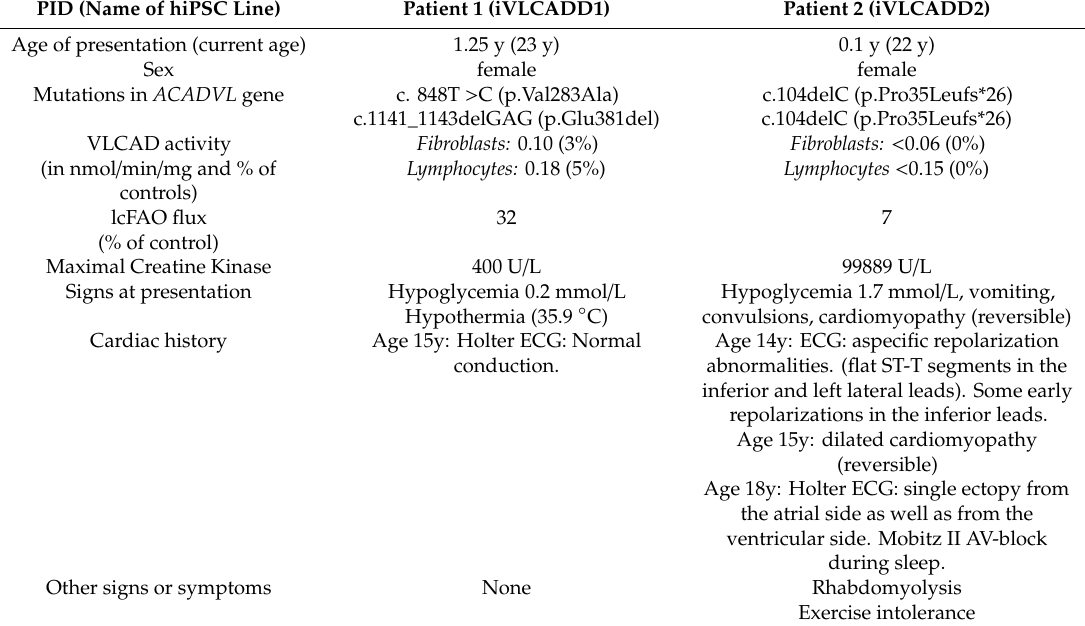
Table 1. Clinical and biochemical characteristics of